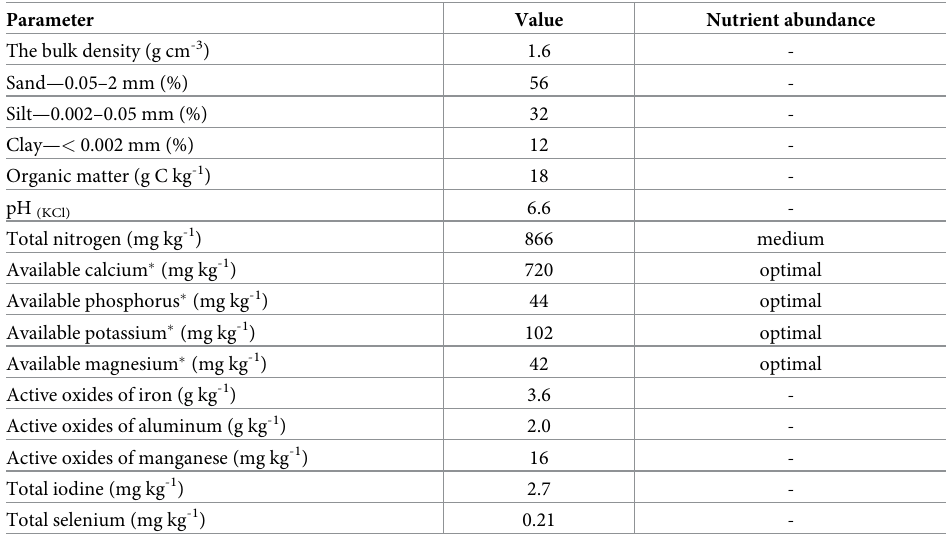
Table 1. Soil characteristics of the layer of 0–30 cm prior to start of the study.